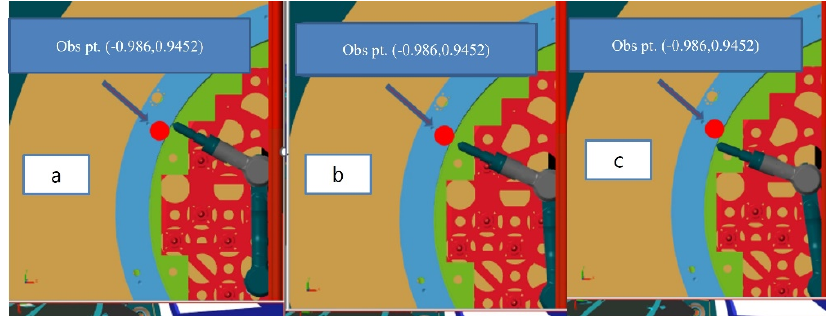
Figure 15. Point obstacle avoidance scenario ( a ) before collision avoidance; ( b ) avoiding collision; ( c ) following desired trajectory after collision avoidance.